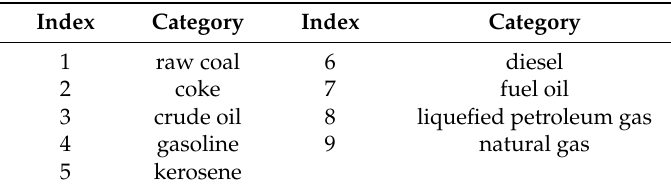
Table 4. Indices for the energy